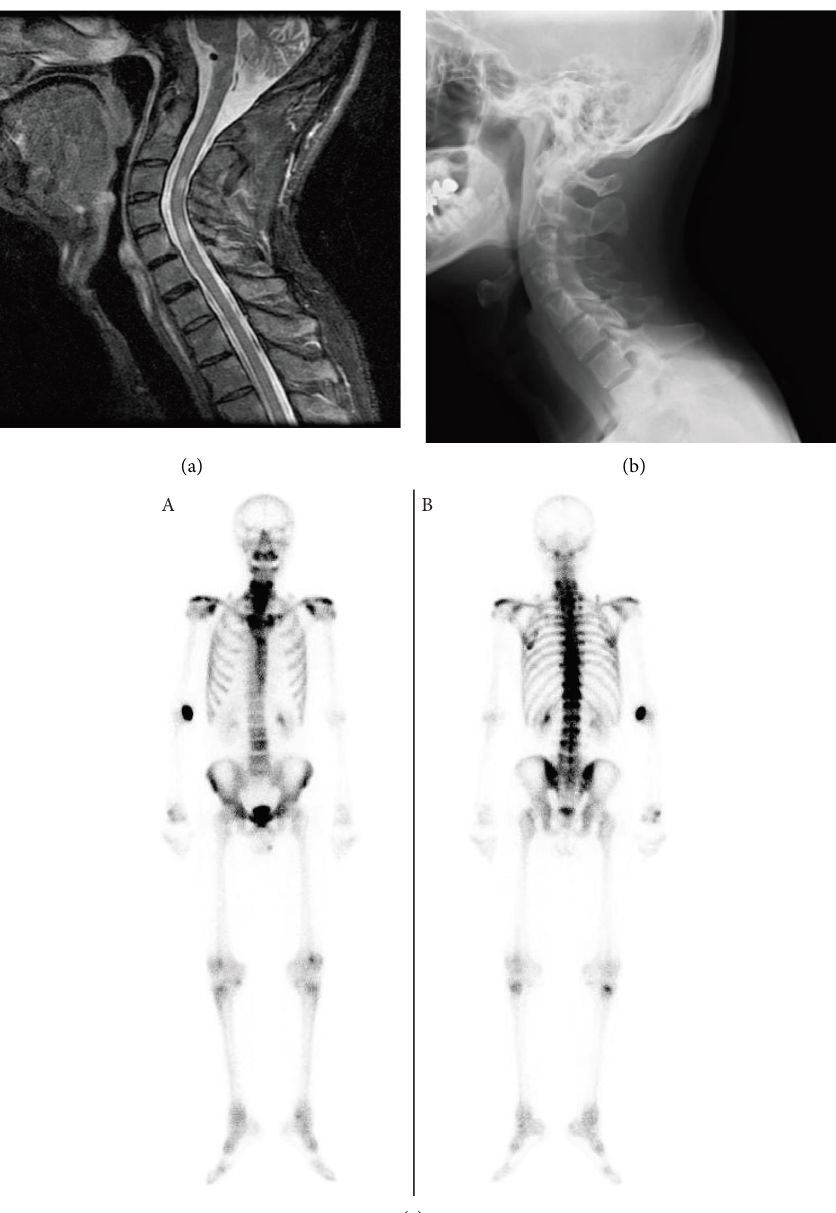
Figure 1: Radiographic images at frst visit: (a) T2WI MRI image of the neck, (b) cervical X-ray, and (c) 99m Tc-HMDP scintigraphy, ventral view (A) and dorsal view (B). Signifcant accumulation in the wrists, knees and sternoclavicular joints is